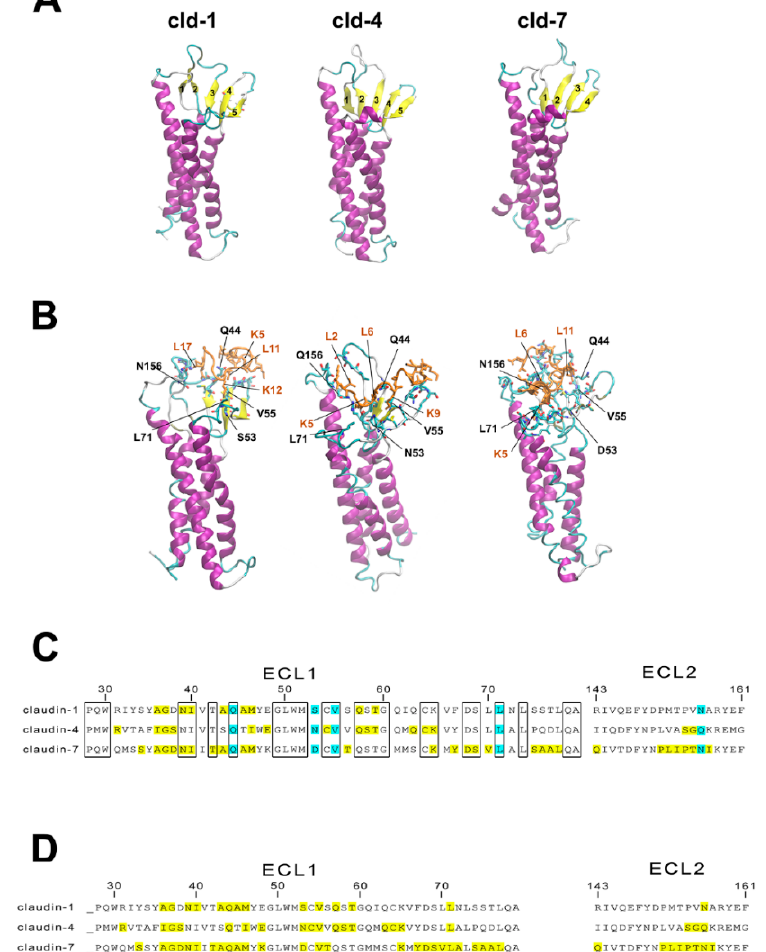
Figure 6. ( A ) Modeling human claudin-1, -4, -7 proteins. ( B ) Docking of PN159 peptide to claudin proteins. Interacting residues are shown as sticks. Orange color: PN159 peptide; Yellow color: β -strands; purple color: α -helices of claudins. ( C ) Amino acid sequence of ECL1 and ECL2 of human claudin monomers 1, 4 and 7. Conserved amino acids are indicated in the boxes. The amino acids which interact with PN159 according to docking studies are marked by yellow and light blue. Blue color indicates interaction between the amino acids of claudins and PN159 peptide at the same position in all three claudins. ECL: extracellular loop. ( D ) Interaction between PN159 peptide and human claudin monomers 1, 4 and 7. Amino acids of PN159 peptide which interact with the claudins according to docking.